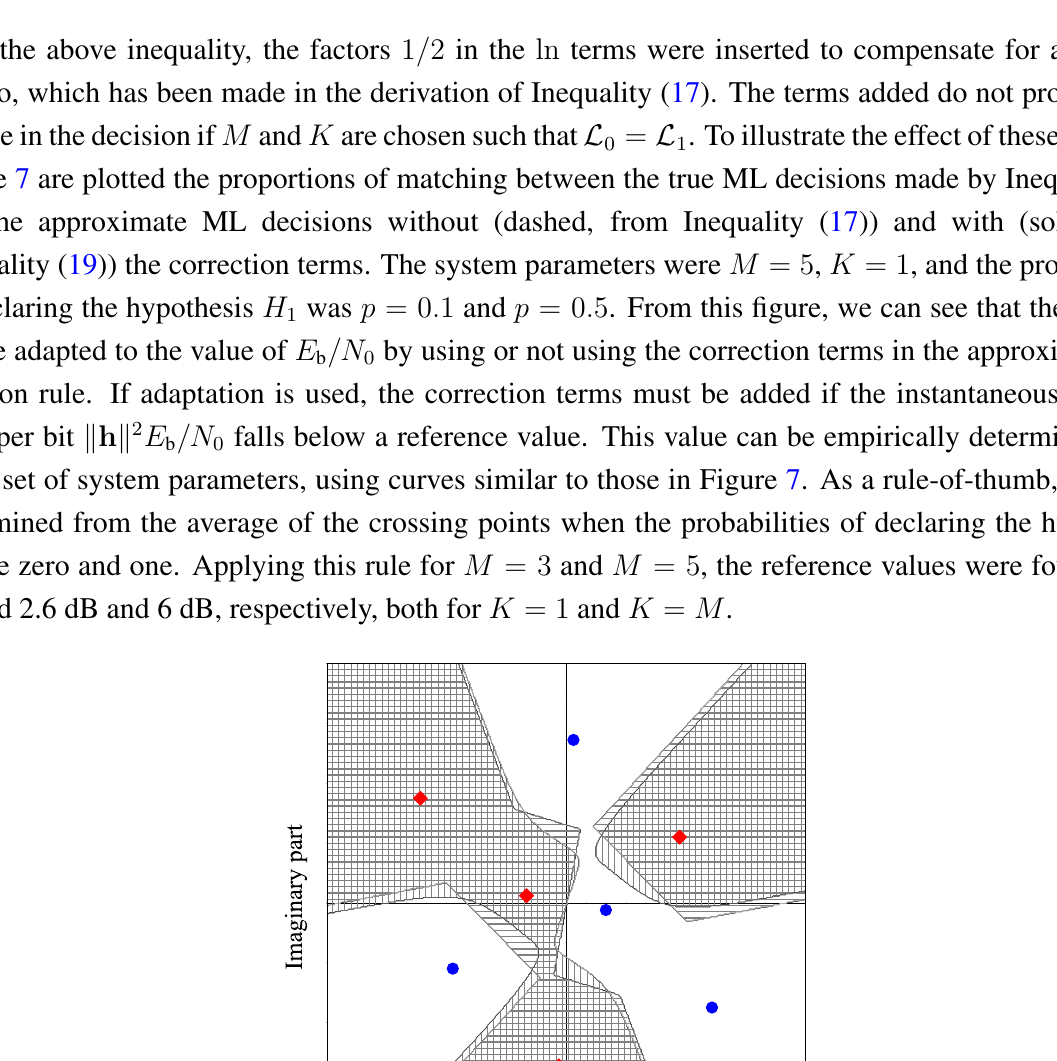
and the approximate ML 1 and the true ML 1